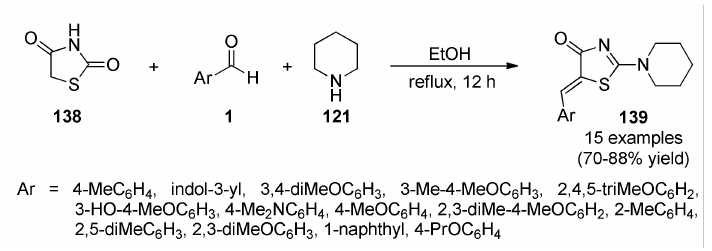
Scheme 64. Three-component synthesis of 5-arylidenethiazolidinones 139 for screening of their in vitro antitumor activity against human Breast cancer